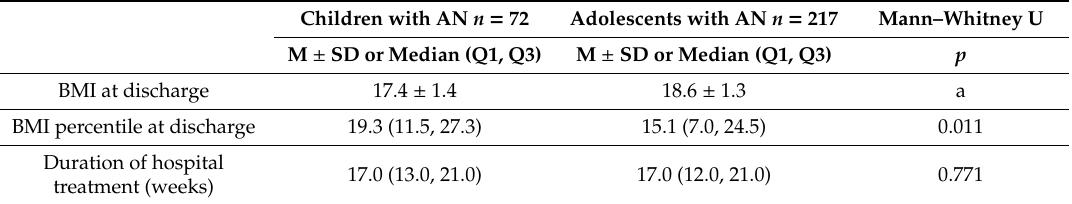
Table 2. Clinical characteristics at